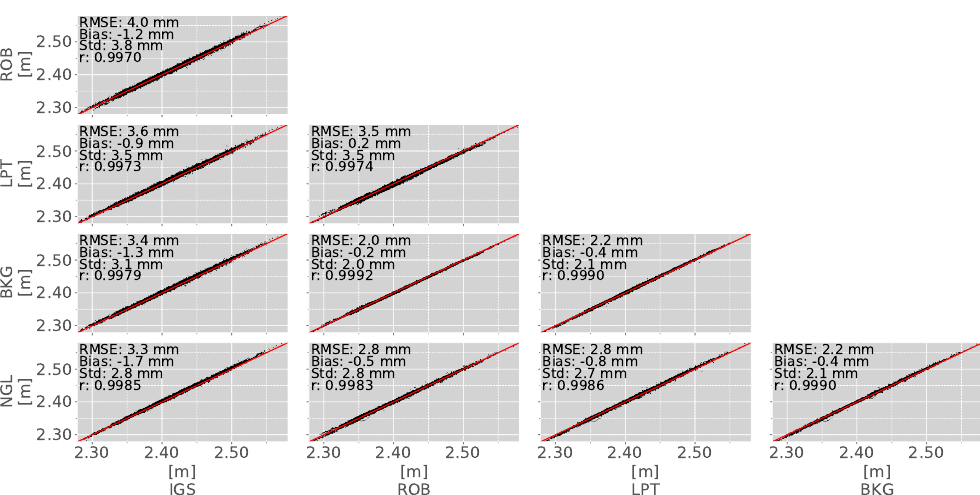
Figure 2. ZTD scatter plots of all post-processed reference datasets at DLF1 in 2017. The solid red line depicts the regression line. RMSE, bias, and std values are in millimeter. The r-value depicts the correlation.